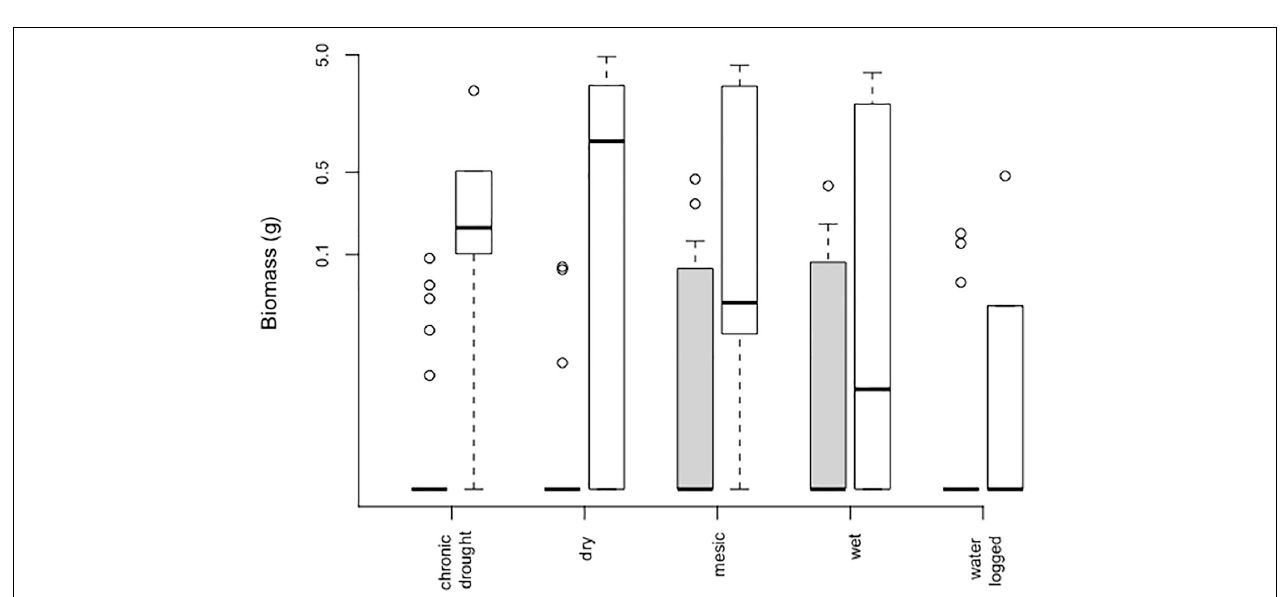
FIGURE 3 | Aboveground biomass of Bunias orientalis over 3 years (2016–2018) depending on water table depth treatment in the community (gray bars, n = 24 each) and empty pot (white bars, n = 6 each). Boxplots show the median per group (solid line), boxes represent the 25th and 75th quantile, whiskers the normal data range and circles the outliers. The y-axis is shown on a log-scale.